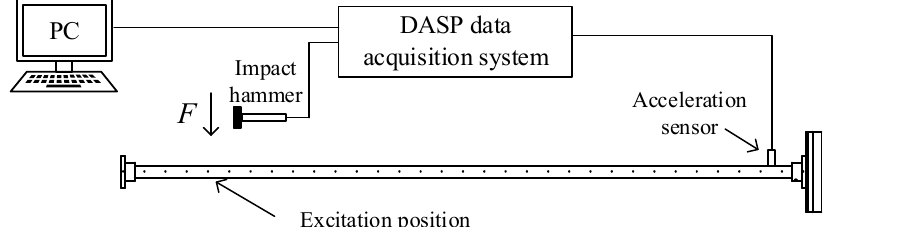
Figure 4. Schematic of EMA Experimental Setup.